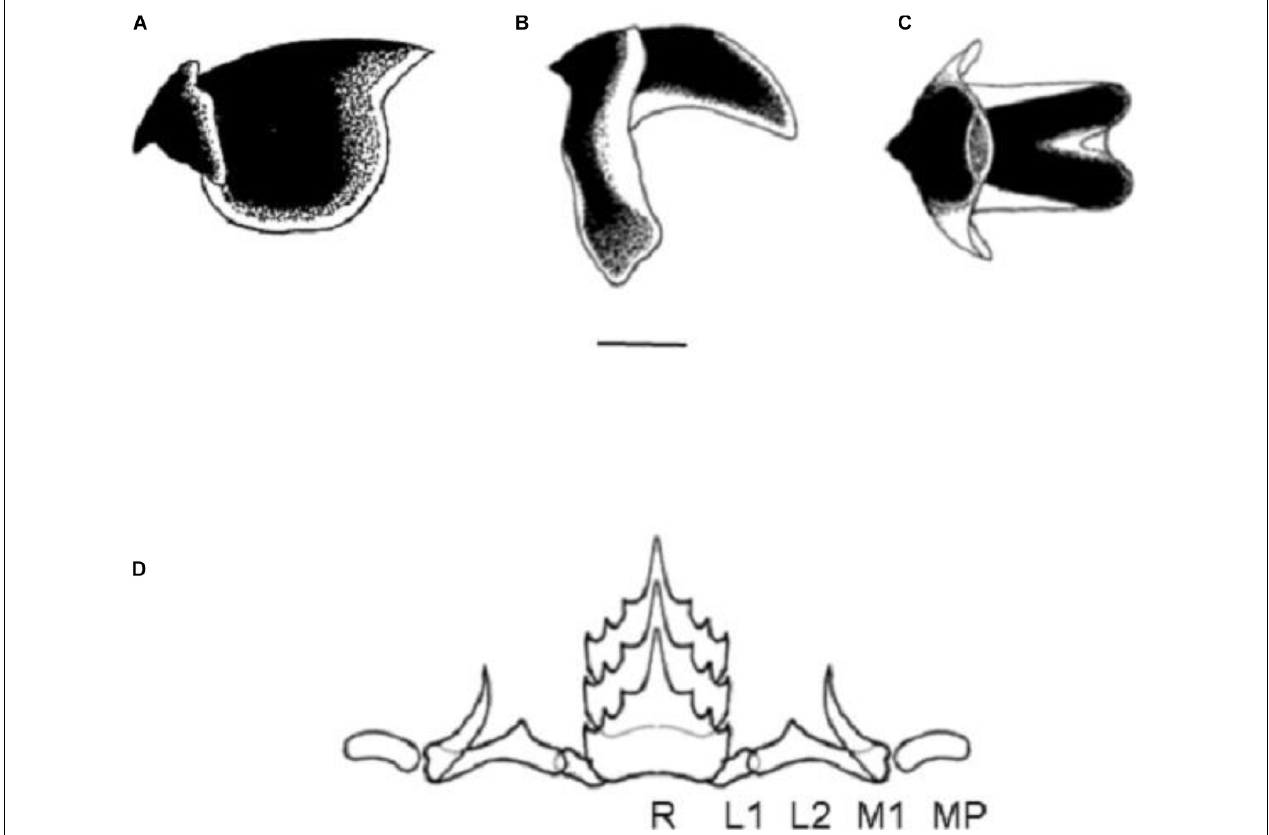
FIGURE 4 | Callistoctopus furvus . (A–D) Neotype (95 mm ML MZUSP 152154). (A) Upper beak, lateral view of. (B) Lower beak, lateral. (C) Lower beak, tripod orientation. (D) Radula. Abbreviations: L1, first lateral tooth; L2, second lateral tooth; M1, first marginal tooth; MP, marginal plate; R, Rachidian tooth. Scale bars (A–C) : 5